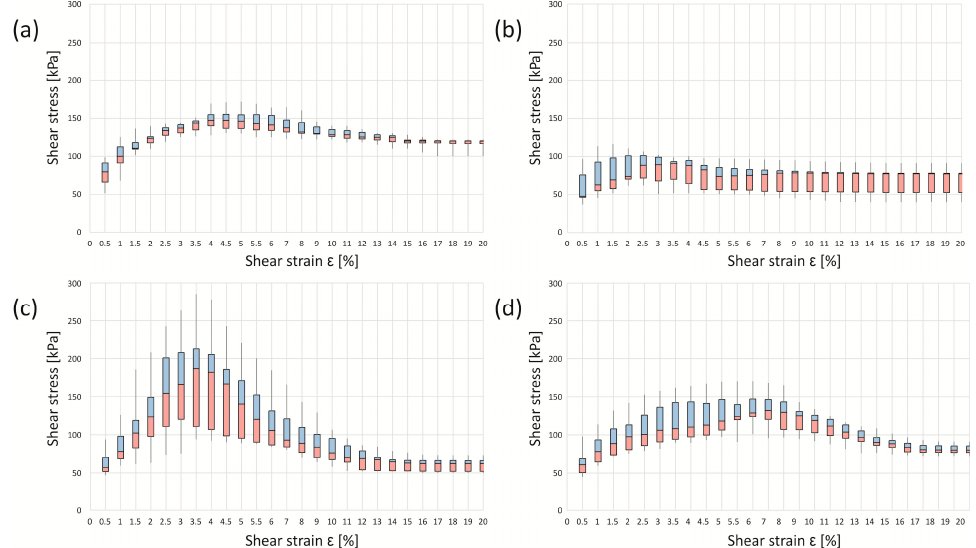
Figure 7. Histograms of shear stress vs. shear strain dependence for lithological units: ( a ) clay–sand unit LI; ( b ) clay of the LII unit; ( c ) clay–lignite–silt unit LIII; ( d ) lignite unit LIV. The upper edge of the box indicates quartile III, and the lower edge is quartile I. The boundary line in the box indicates the arithmetic mean. The values between quartile I and the arithmetic mean are marked in orange. The values between quartile III and the mean value are marked in blue. The lines above and below the block indicate the minimum and maximum values.